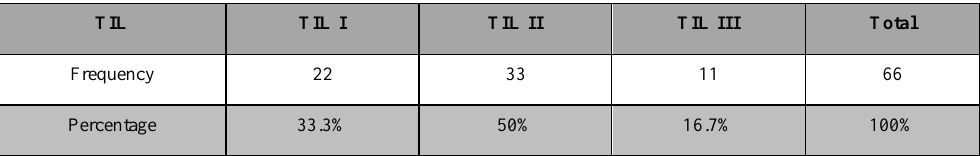
Table 2. TIL Score